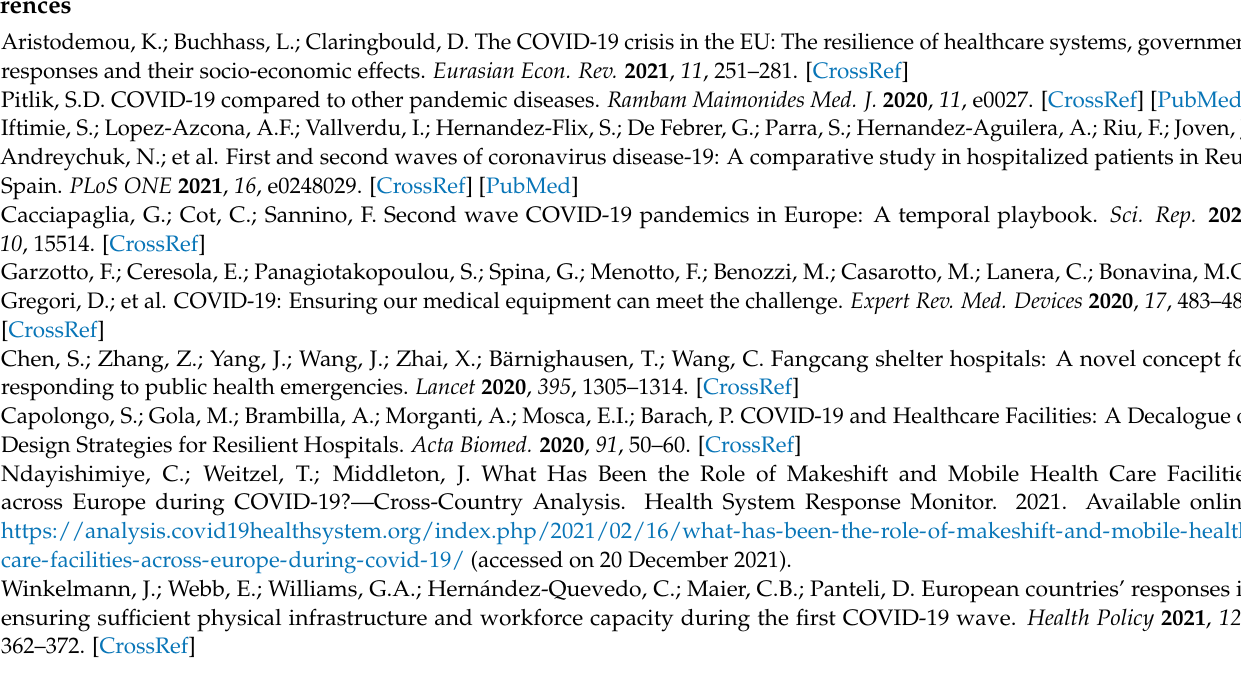
empirical papers. Table S3. Search Results in PubMed. Table S4. Search Results in Scopus. Table S5. Search Results in Web of Science. Table S6: List of all studies included. Table S7. Results of five included review